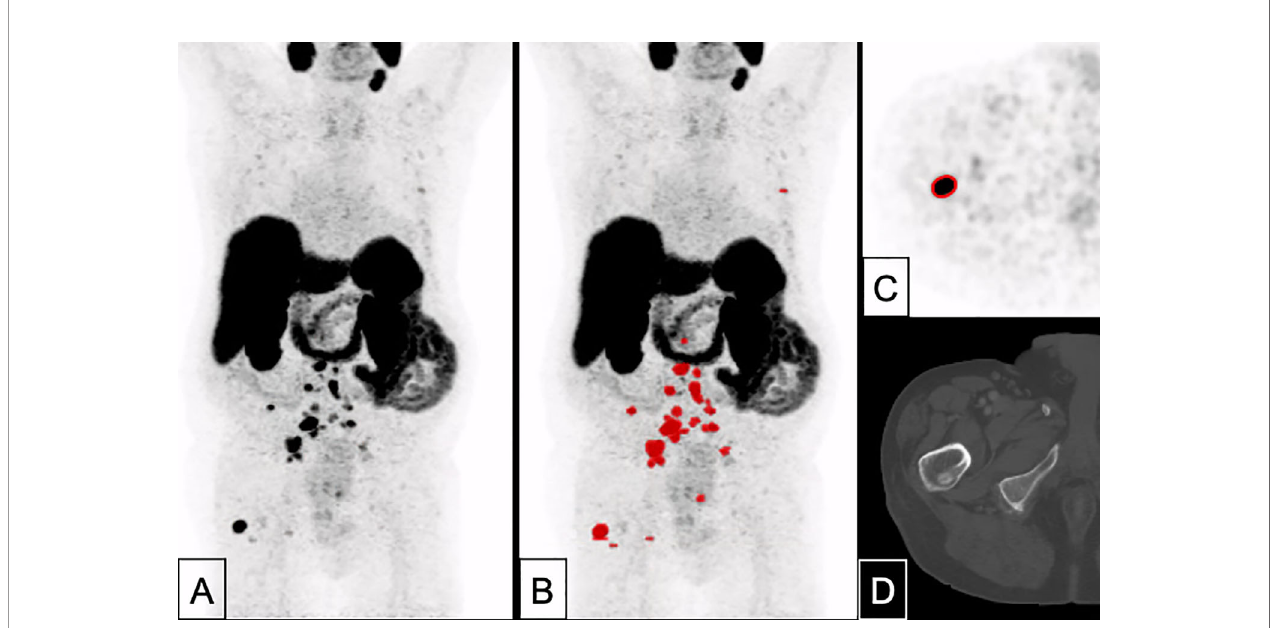
FIGURE 4 | A 82 years-old patient with prostate cancer remnant as well as bone and lymph node metastases (PSA 10.1 ng/ml, Gleason 8). Tumor delineation using a cut-off of SUV 4.0 revealed a WTV of 37.9 ml. (A) maximum intensity projection (MIP); (B) MIP + WTV (red color); (C) delineation of a bone metastasis on PET; (D) CT correlate (bone window).